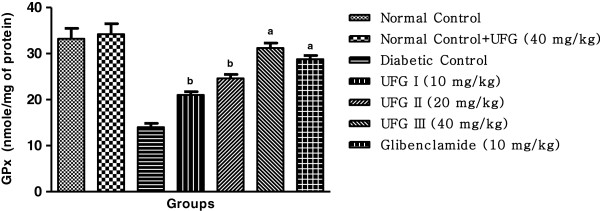
Effect of umbelliferone β-D-galactopyranoside on level of GPx (Glutathione peroxidase) cholesterol at different concentrations on STZ induced diabetic rats, compared to diabetic control group rats; values are mean ± SEM; n = 6;
c
P < 0.05;
b
P < 0.01;
a
P < 0.001; P > 0.05 is considered as non-significant (ns).